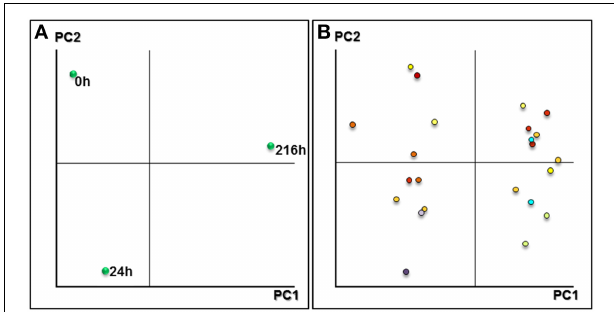
FIGURE 2 | Principal component analysis plots. (A) Representation of the samples based on the main principal components found after PCA. (B) Plot component PC1 vs. PC2 of differentially expressed spots in three stages